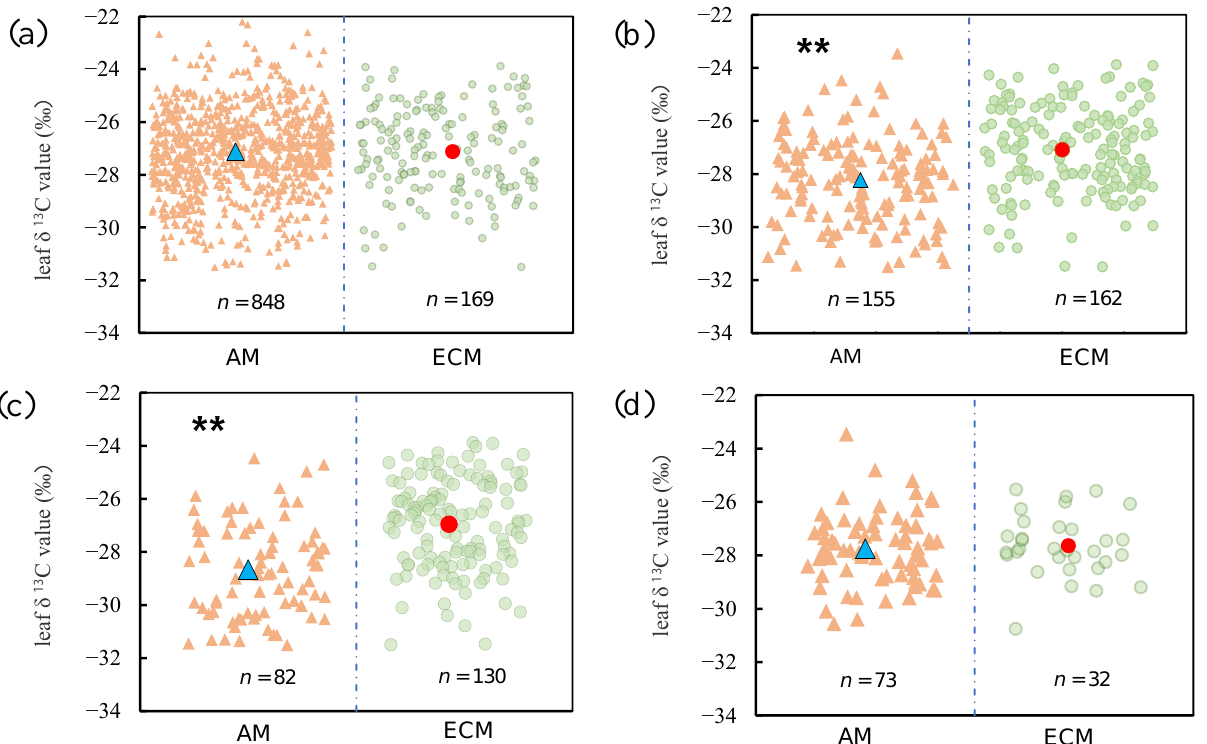
Figure 1. Leaf δ 13 C values of AM and ECM plants with different life forms. ( a ) Total plants, include all plants in the database without distinguishing their life forms ( b ) Trees, only contain all the tree species in the database ( c ) Evergreen trees, only contain all evergreen trees of the tree species ( d ) Deciduous trees, only contain all deciduous trees of the tree species. All yellow triangles represent AM plants and all green rectangles represent ECM plants. The blue triangle represents the average of leaf δ 13 C values of AM plants and the red circle represents the average of leaf δ 13 C in ECM plants. The asterisks above the line bars show the results of one-way ANOVA at the level of p < 0.05. Two asterisks indicate extremely significant differences.